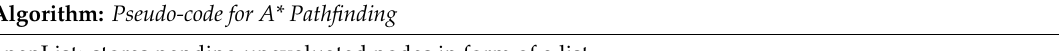
Table A1. Pseudo-code for A* search algorithm. Algorithm: Pseudo-code for A*